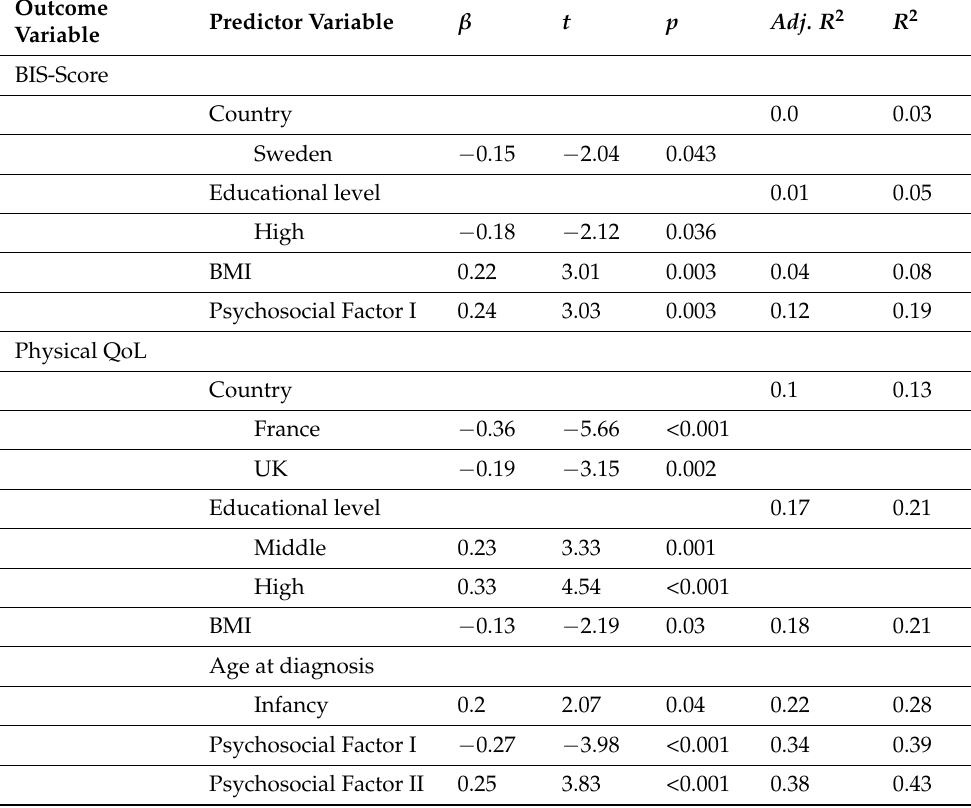
Table 5. Linear Regression models of the outcome